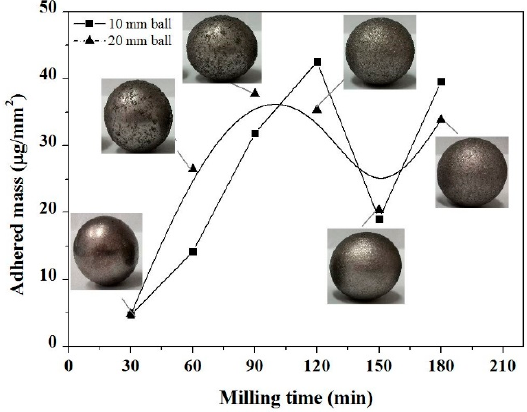
Figure 4. Effect of milling time on the value of adhered mass on the surface of milling balls.